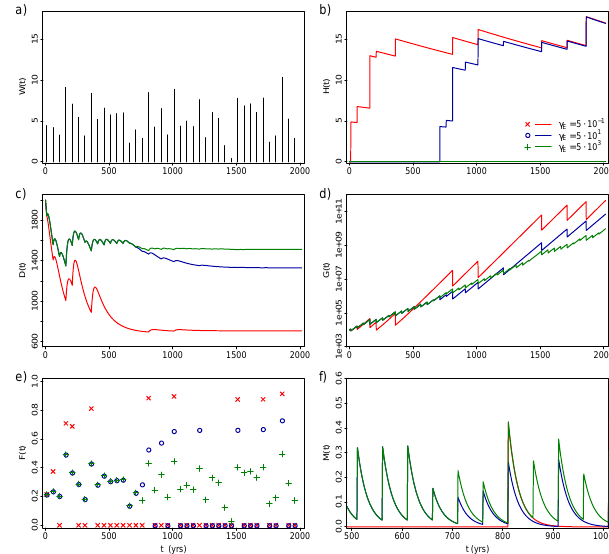
Fig. 4. The evolution of WetTown assuming a fast decay of pro- tection levels (i.e. κ T = 3 × 10 − 3 yr − 1 ): (a) high water levels [m]; (b) flood protection levels [m]; (c) distance of WetTown from Wild- Waters River [m]; (d) size/wealth of WetTown [m 2 ]; (e) relative flood damages [.]; (f) awareness of the risk of flooding [.]. The colour of lines and points refers to the three scenarios: low-cost (red), moderate-cost (blue) and high-cost (green).